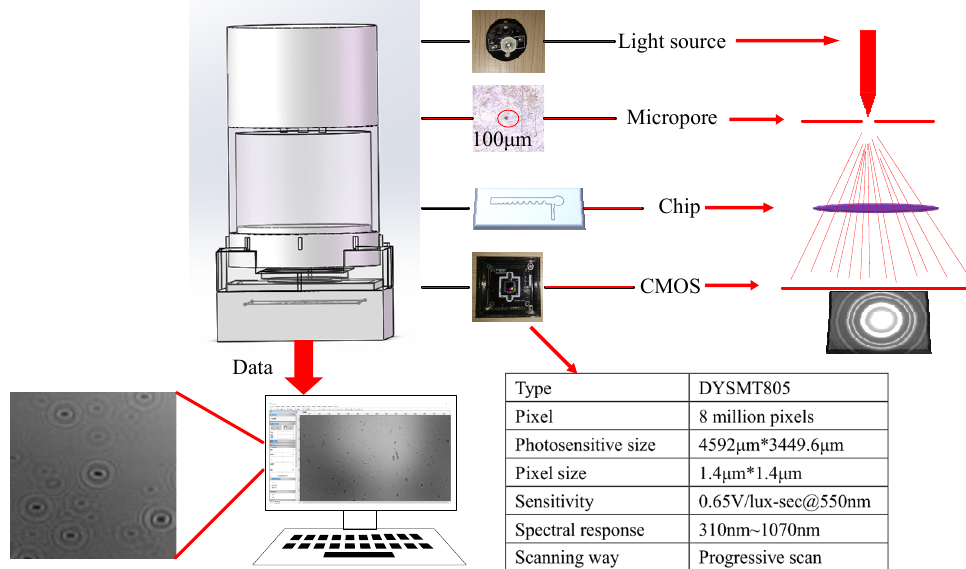
Figure 3. Diffraction imaging detection platform.